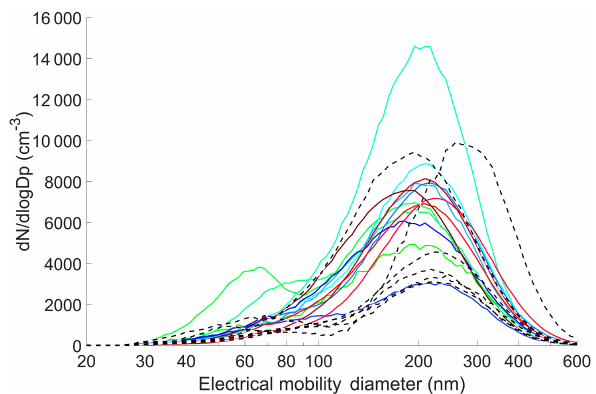
Figure 7. Event-integrated aerosol number size distributions (cor- rected to STP) in d N/ dlog Dp (no.cm − 1 ) . The regional BB events have solid colored lines and the Siberian BB events have dashed black